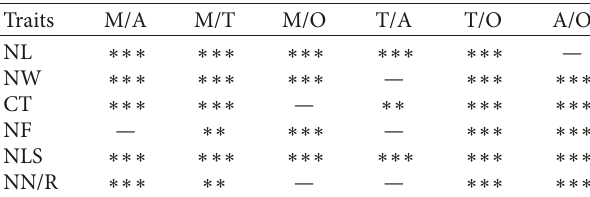
Table 3: Differences between analyzed characters of needles of populations in Tukey’s test and Kruskal–Wallis